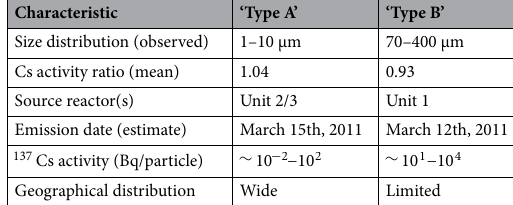
Table 1. Comparison of ‘Type A’ and ‘Type B’ particle properties. Adapted from 16,19 .